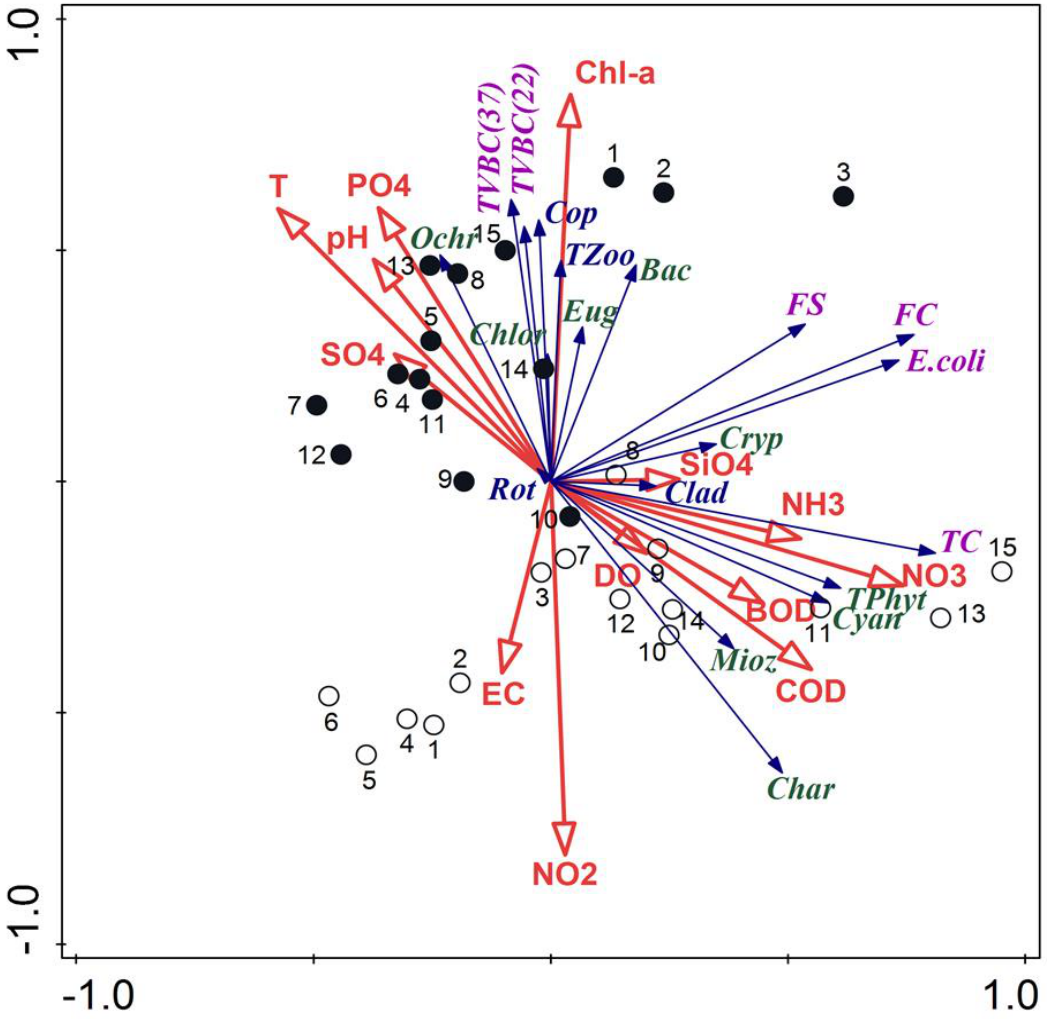
Figure 6. Triplot diagram of RDA of planktonic organisms and the main physicochemical parameters; empty circles — samples from the post-flood period, black circles — samples from the pre-flood period; codes of plankton are explained in Figure 4, codes of the physicochemical parameters are explained in the Materials and Methods (including PO4 — PO 4 , SO4 — SO 4 , SiO4 — SiO 4 , NH3 — NH 3 , NO3 — NO 3 , NO2 — NO 2 ).